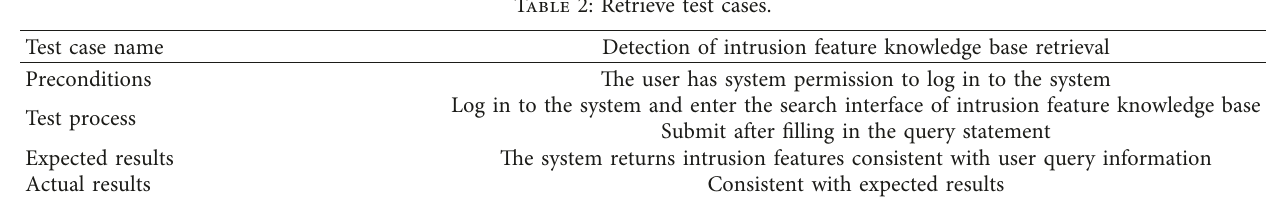
Table 2: Retrieve test cases.